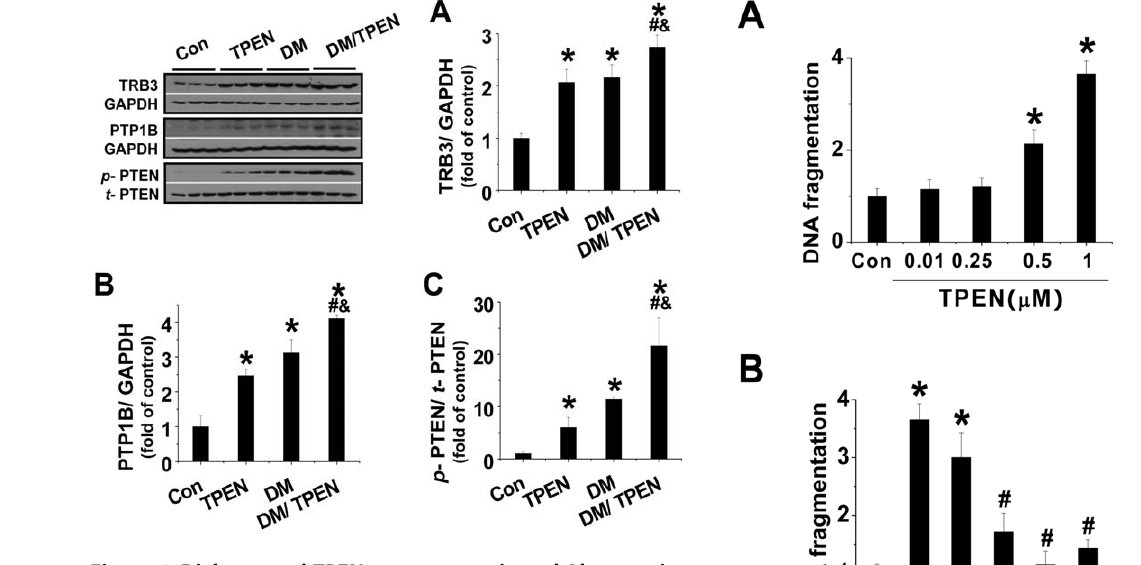
Figure 6. Diabetes and TPEN treatment activated Akt negative regulators. Hepatic expressions of TRB3 (A), PTP1B (B), and phosphorylated PTEN (C) were examined by Western blotting. Data are presented as mean 6 SD (n=6 at least in each group). DM: diabetes. * P , 0.05 vs. control group; # P , 0.05 vs. TPEN group; & P , 0.05 vs. DM group.